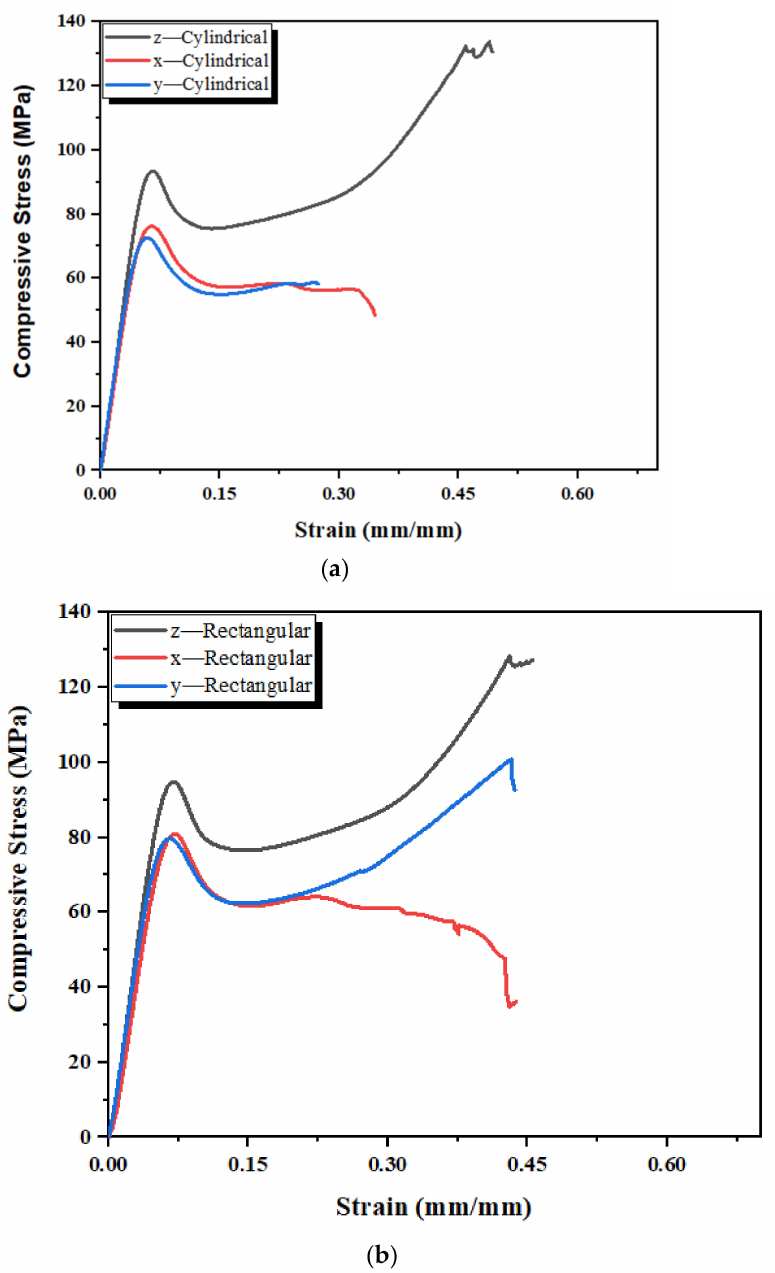
Figure 13. Stress–strain curves of 3D-printed standard samples in the x -, y -, and z -directions. ( a ) Stan- dard sample with cylindrical cross-section; ( b ) Standard sample with rectangular